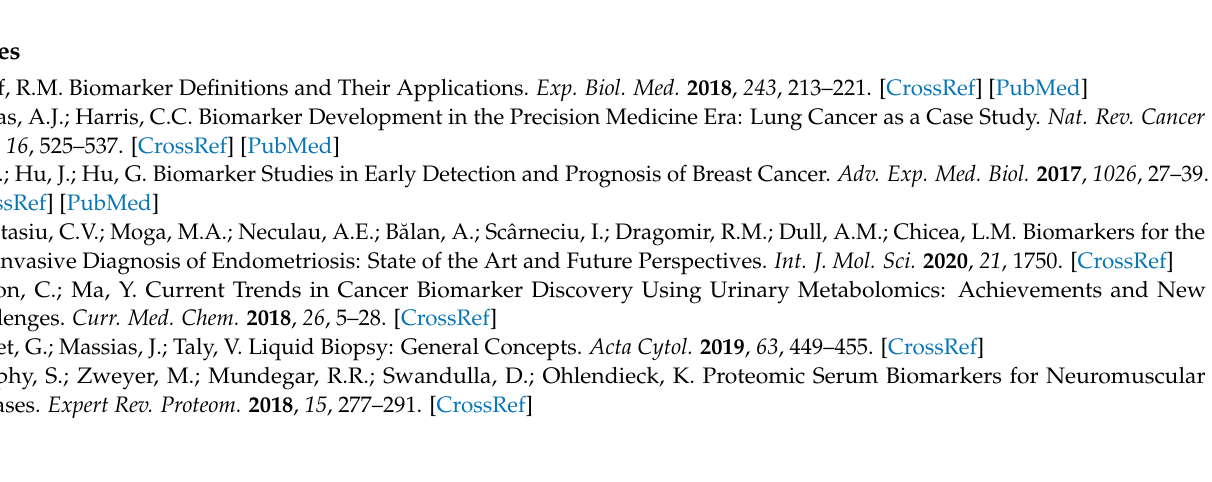
peptide selections, Table S2: Proteins used for binding specificity assays, Table S3: Titers, blocking agents, and stringency for PvP Fab